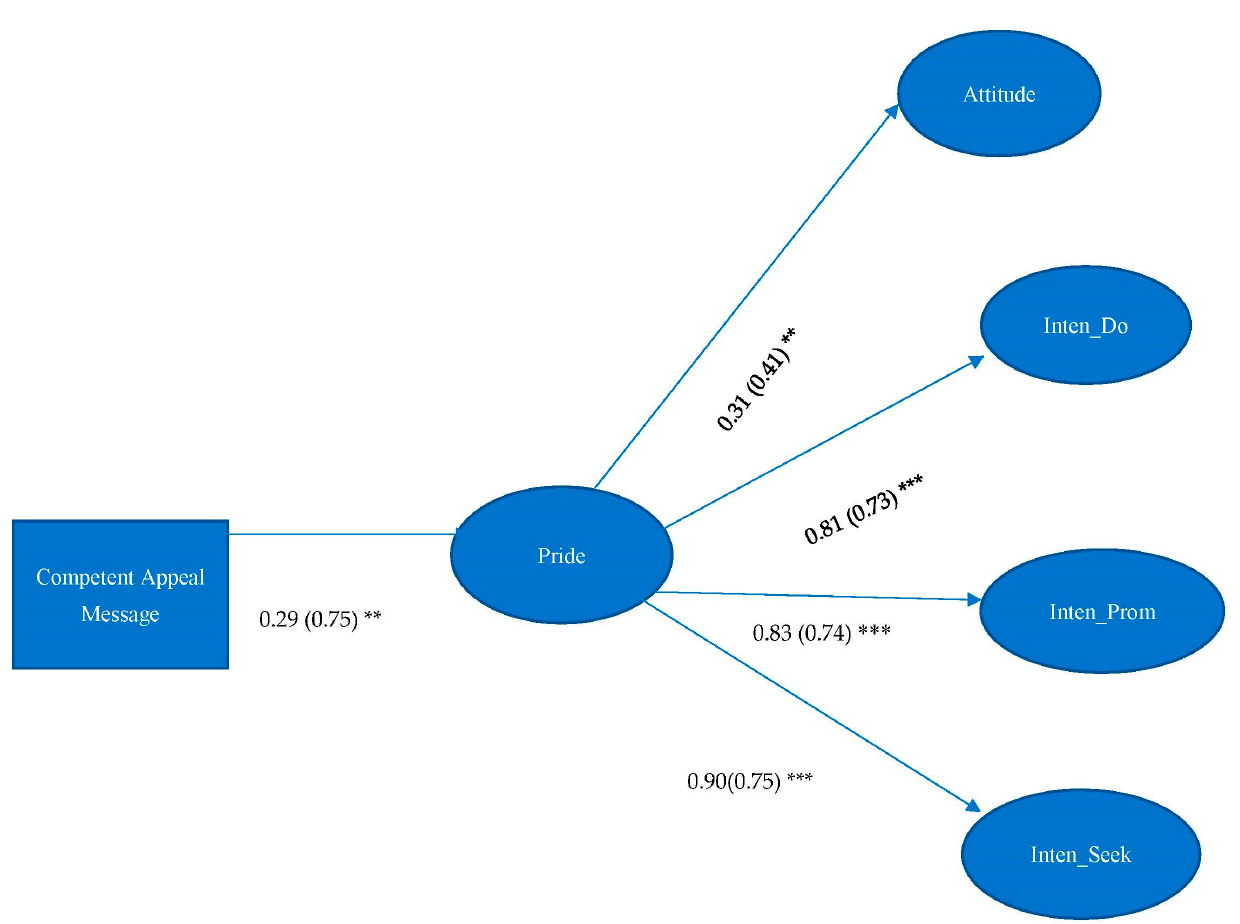
Figure 5. Unstandardized estimates are listed, followed by standardized estimates in parentheses. Model Fit: χ 2 = 383.626, df = 202, p < 0.001; RMSEA < 0.001, 90% C.I.: 0.060–0.081, CFI = 0.934, SRMR = 0.058. Note: ** p < 0.01. *** p < 0.001. Attitude = Attitude toward organ donation, Inten_Do = Inten-